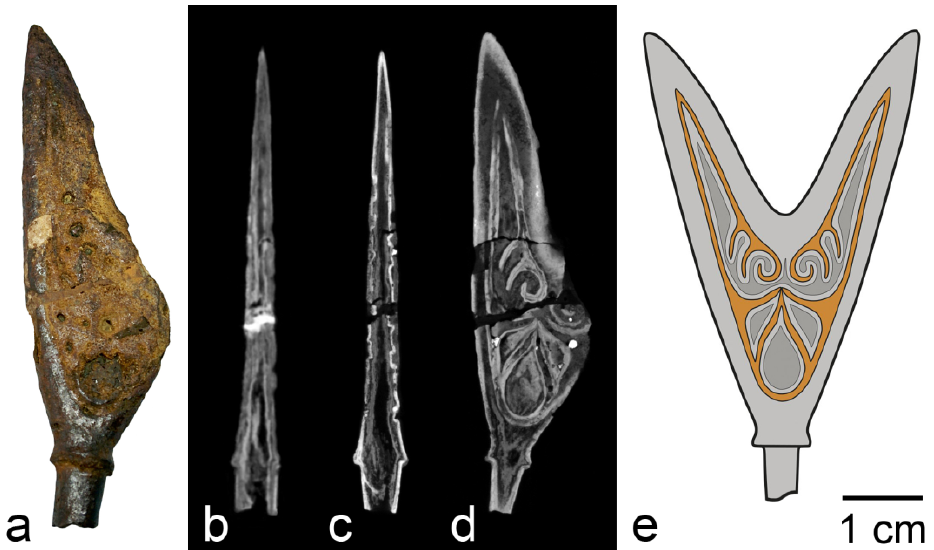
Figure 5. Study of the arrowhead: ( a ) photograph of the object; ( b ) neutron tomographic slice; ( c ) SR tomographic slice; ( d ) SR tomographic slice in plane of ornament; ( e ) reconstruction of initial appearance of the arrowhead.